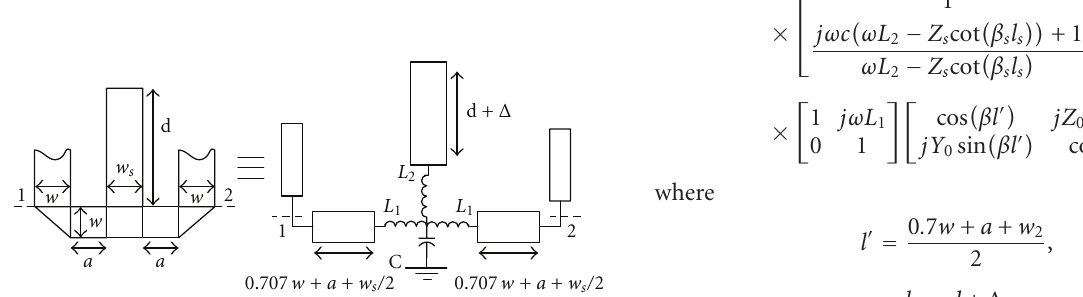
Figure 10: Comparison of the group delay of example 3 as obtained by the simulation softwares (IE3D and HFSS) and measurement data (Example 2).